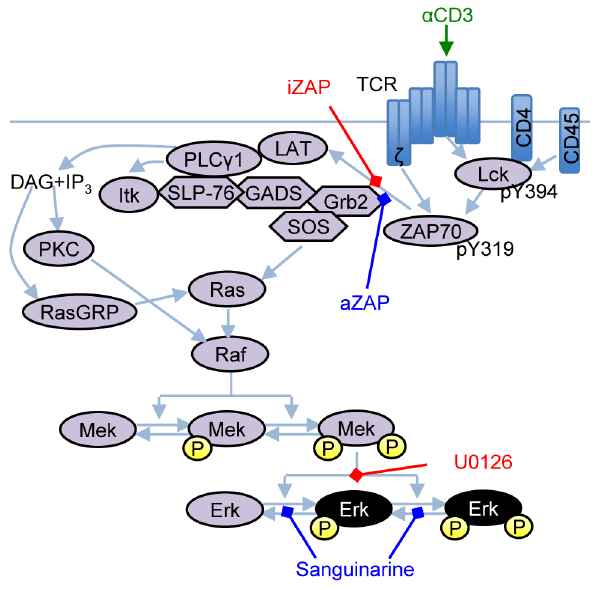
Figure 1. Generalized illustration of the TCR-mediated signal- ing pathway through the Erk-MAPK cascade. Arrow- and diamond-heads denote activation and inhibition of substrate mole- cules, respectively. TCR stimulation is achieved through a CD3 (green) binding. Subsequent Erk activation (black) controlled using small molecule inhibitors sanguinarine (blue) and U0126